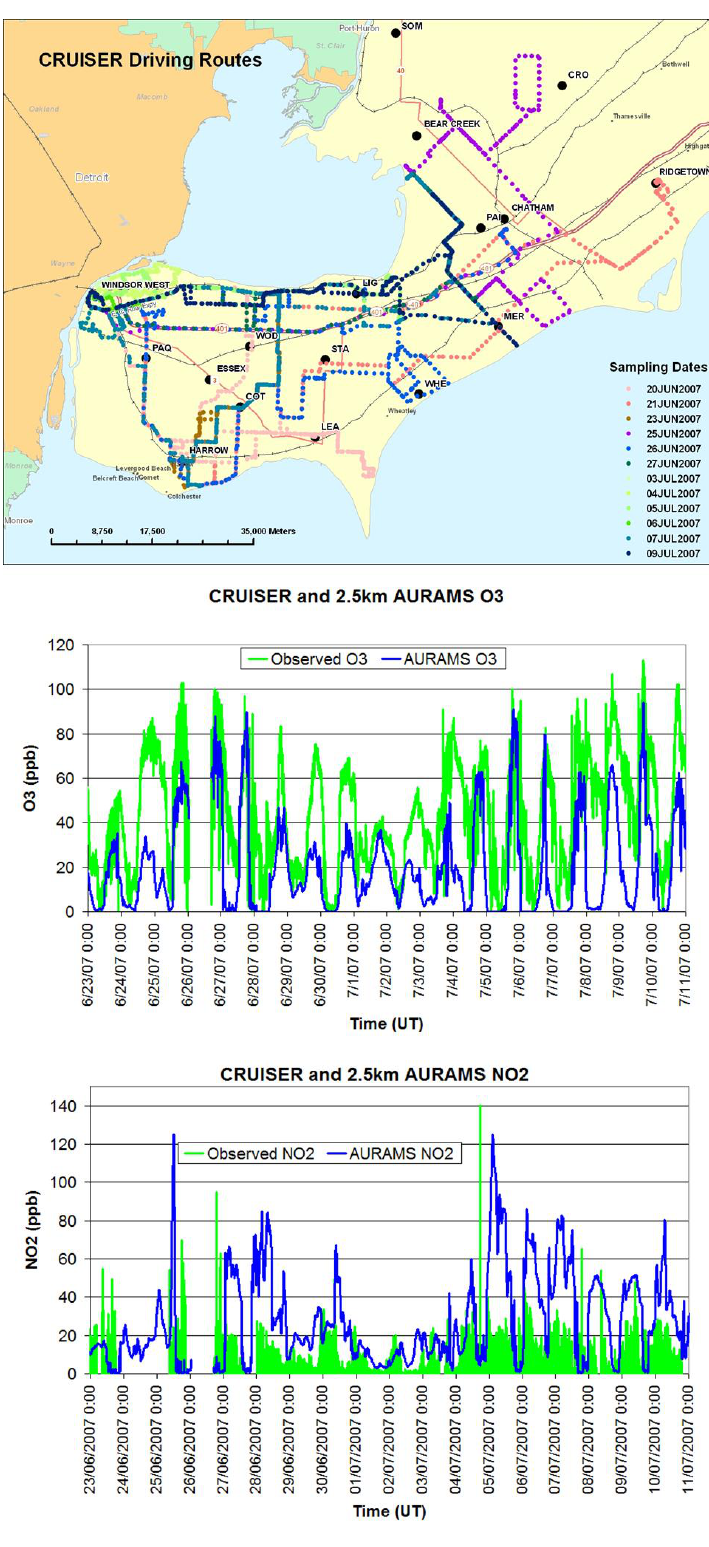
Fig. 6. (a) CRUISER driving routes during the intensive, (b) observed and model-simulated ozone along CRUISER driving routes, (c) observed and simulated NO 2 along CRUISER driving